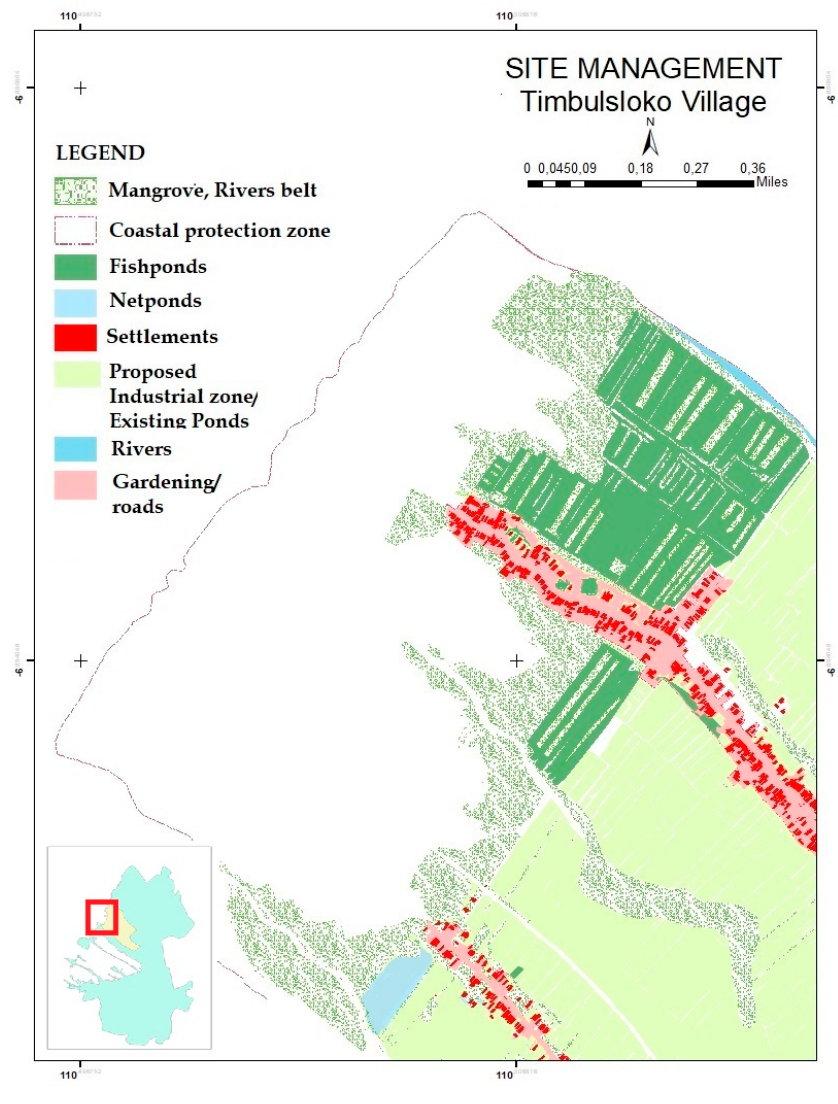
Figure 8. Site-planning management of SPBEA.